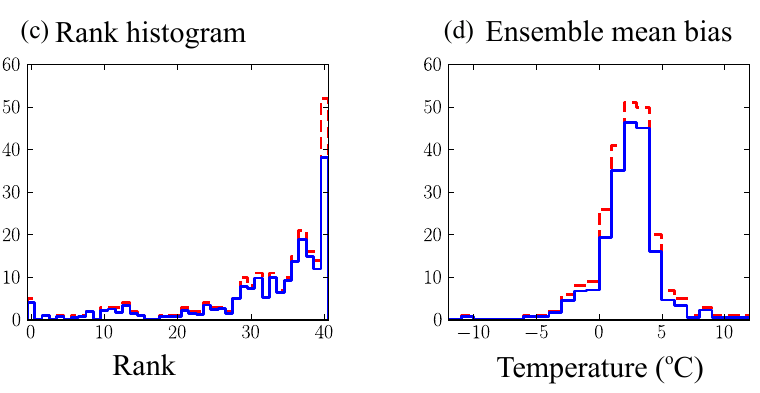
Fig. 8. Rank histogram analysis for the JUMP ensemble JUMP analysis with (c–d) and without (a–b) inclusion of MARGO data uncertainty. ( a and c ) Area-weighted, and point-wise rank histograms. High rank indicates that MARGO is warmer at the LGM than the ensemble. ( b and d ) Histograms of the difference between the JUMP ensemble mean and the MARGO